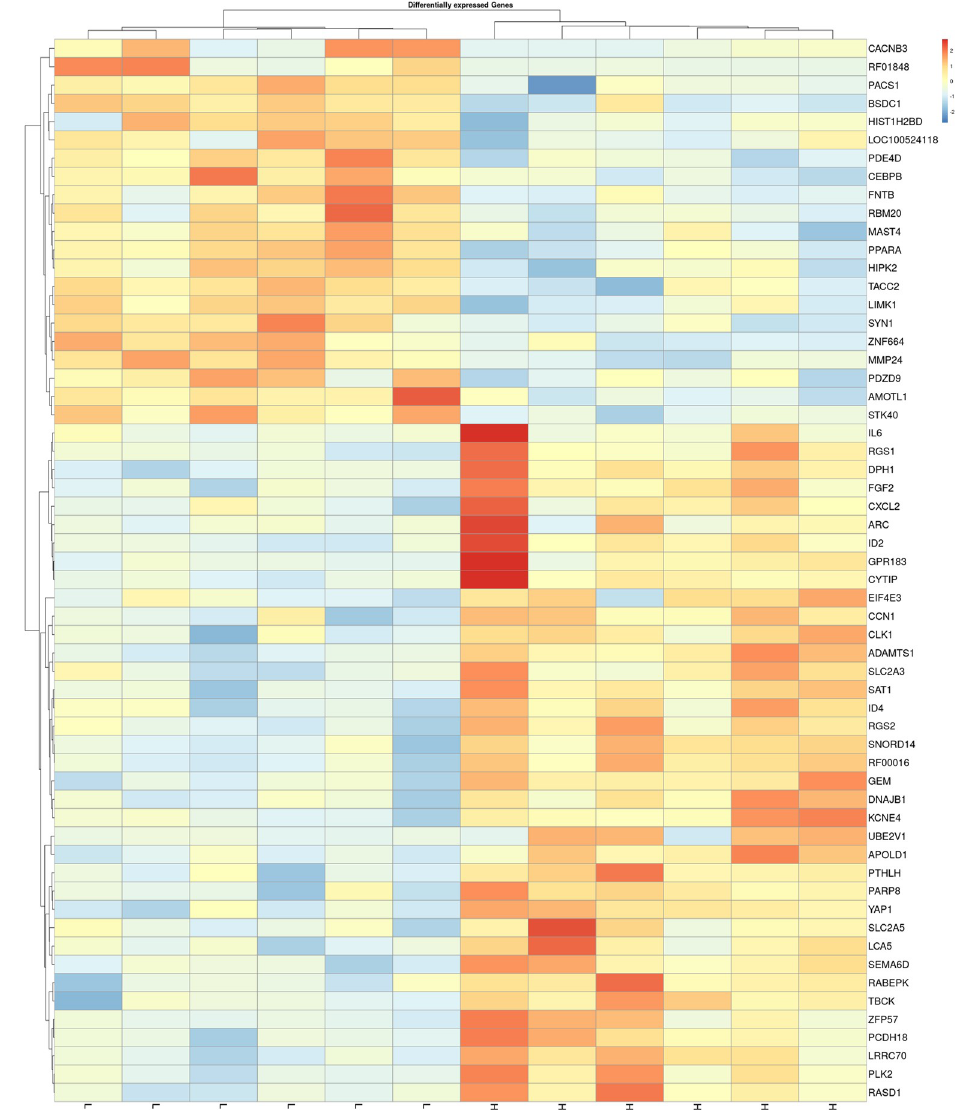
Fig 3. Gene expression unsupervised hierarchical clustering of the 58 differentially expressed genes (DEGs) between low Intramuscular Fat (IMF) vs . high IMF pigs. The color scale bar shows the relative gene expression changes normalized by the standard deviation (0 is the mean expression level of a given gene). H and L indicate the high IMF and the low IMF samples, respectively. The gene named “SNORD14” refers to ENSSSCG00000039904